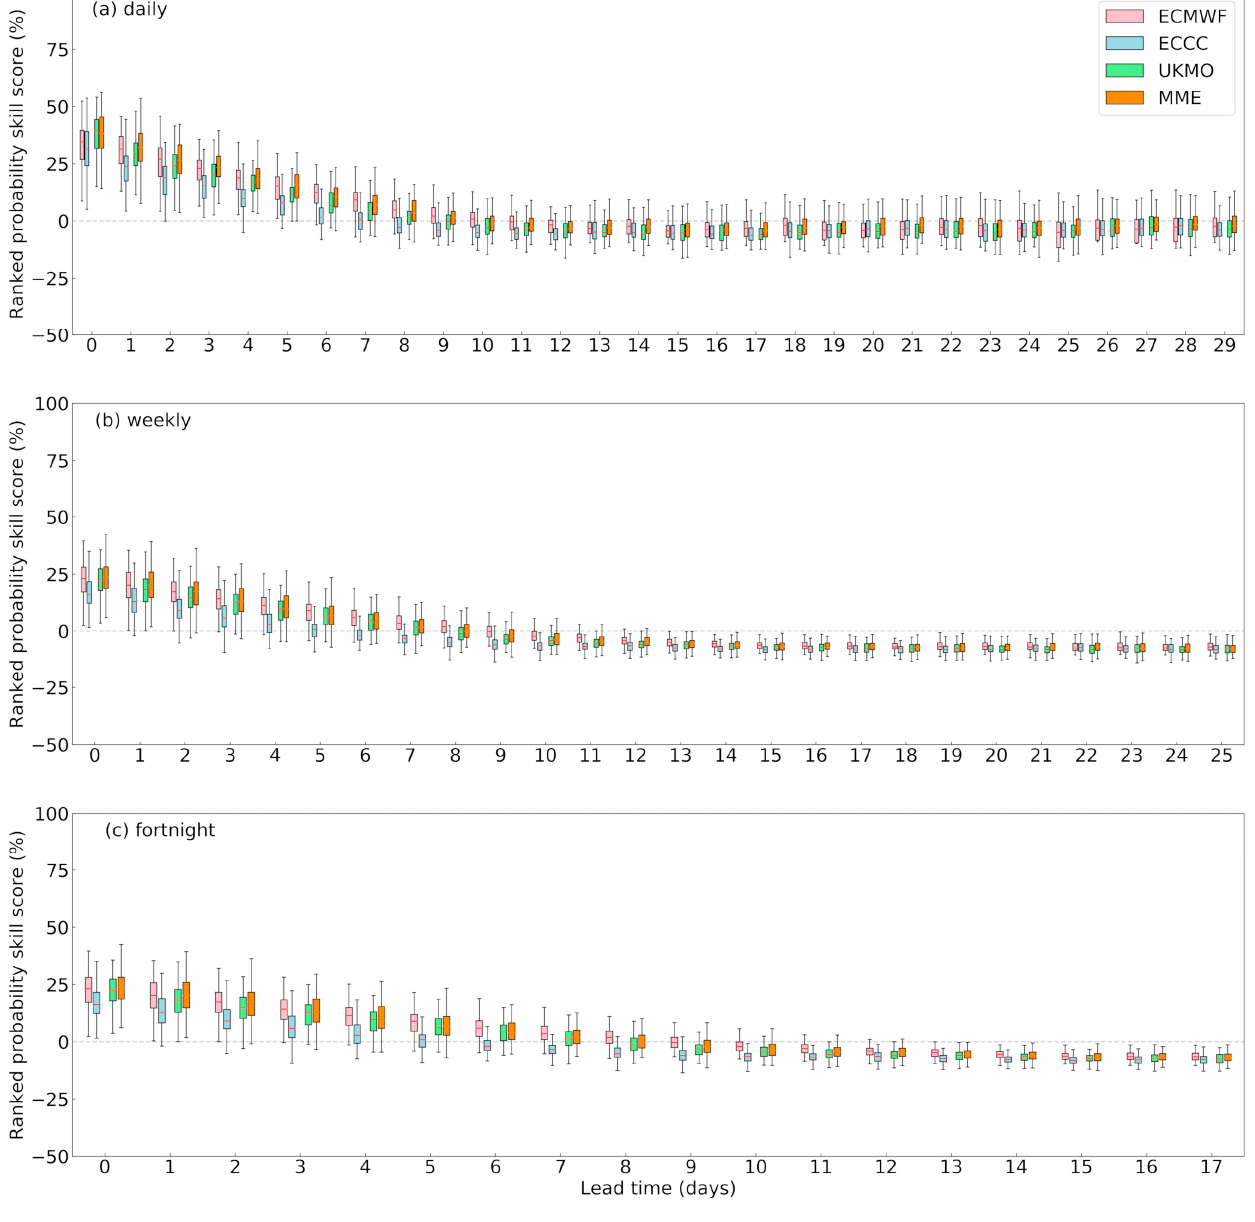
Figure 9. Boxplot diagrams of ranked probability skill score of precipitation forecasts at different temporal scales (daily, weekly, and fortnight) of the ECMWF model, the ECCC model, the UKMO model, and the MME model during the boreal summer monsoon. The box spans the interquartile range (IQR) of mean squared skill scores, while the whiskers span the [0.1, 0.9] quantile range. The red line denotes the median value of mean squared skill scores.